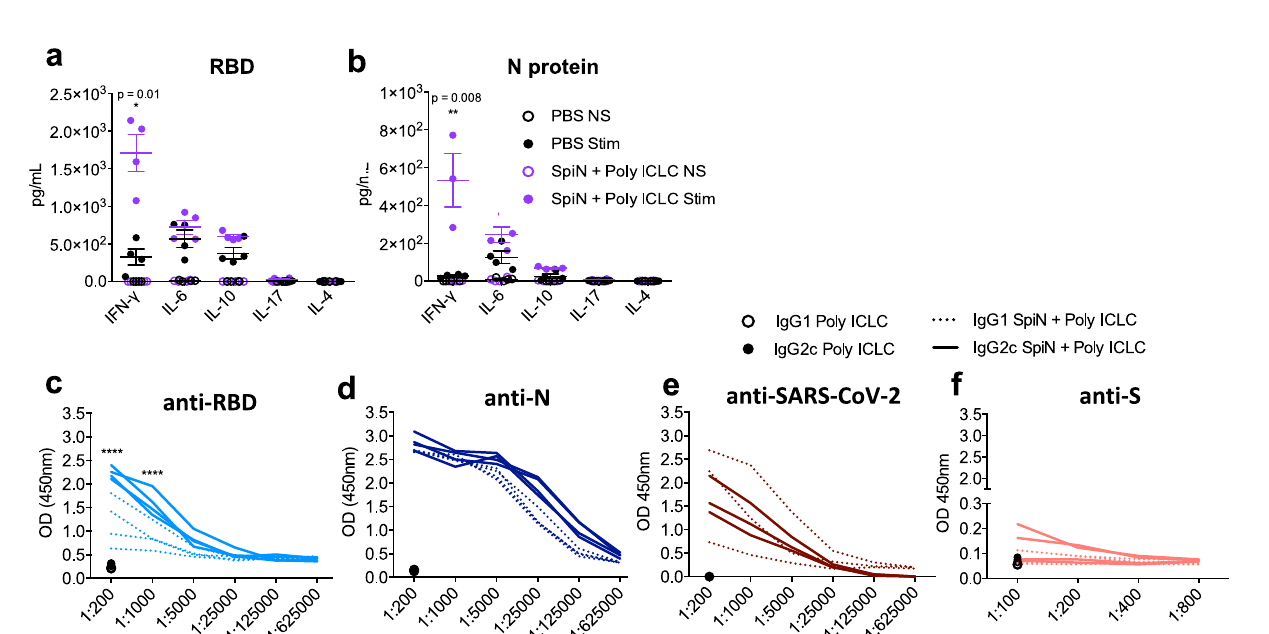
Fig. 3 | Levels of cytokines and anti-SARS-CoV-2 IgG isotypes from mice immunized withSpiN. Levelsof cytokines in the supernatant of splenocytes from control and vaccinated mice stimulated (stim) or not (NS) with the RBD ( a ) and N proteins ( b ), as measured by the cytometric bead array (CBA). The levels of IgG1 andIgG2cspeci fi cforRBD ( c ), N( d ),SARS-CoV-2( e )and S( f )proteinsinserafrom